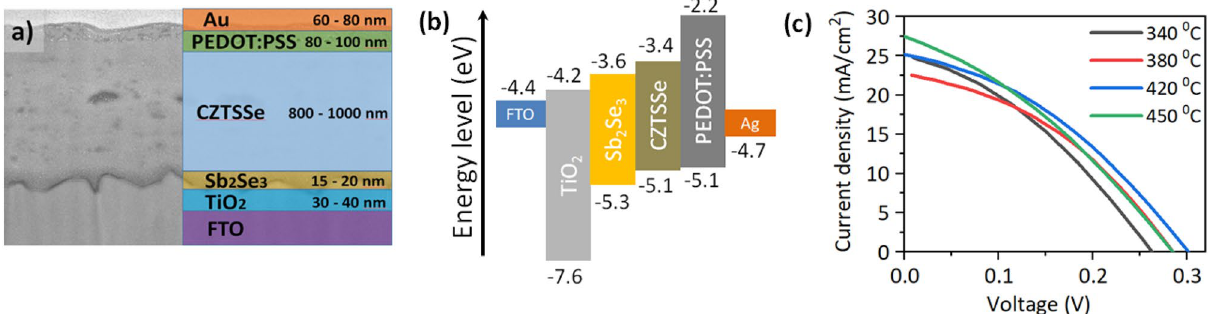
Figure 5. Structure and characteristics of CZTSSe solar cells. FIB-made cross-section SEM (left) and schematic CZTSSe solar device structure (right) ( a ). Energy level diagram of the materials used in CZTSSe solar cell device